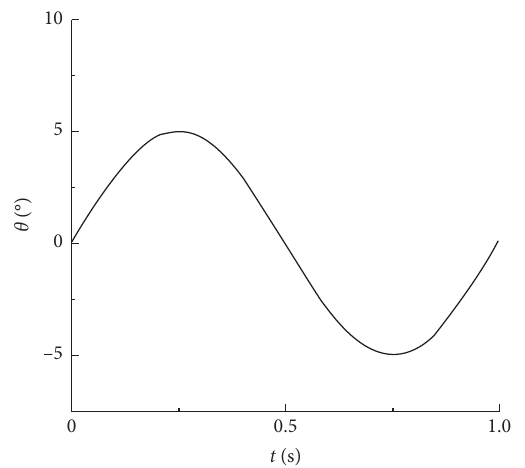
Figure 6: Camber changes over time.